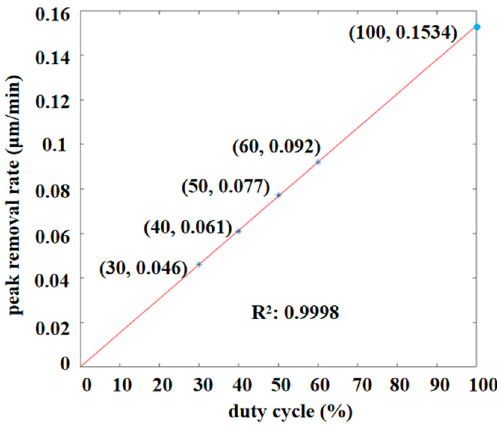
Figure 7. Linear relationship between duty cycle and removal efficiency.